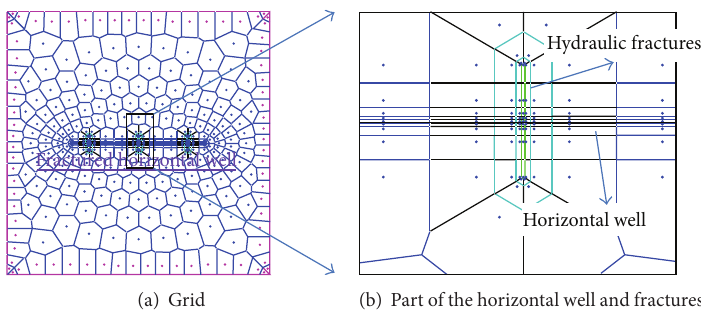
Figure 1: Hydraulically fractured horizontal well grid without cell points in 2D form.